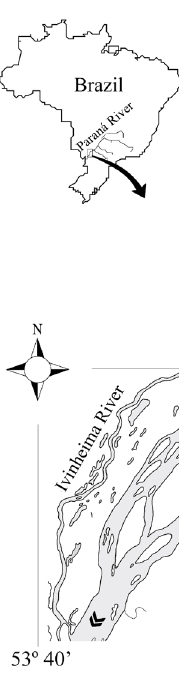
FIGURE 1 | Study area: location of sampling site in the upper Paraná River floodplain, Mato Grosso do Sul State,